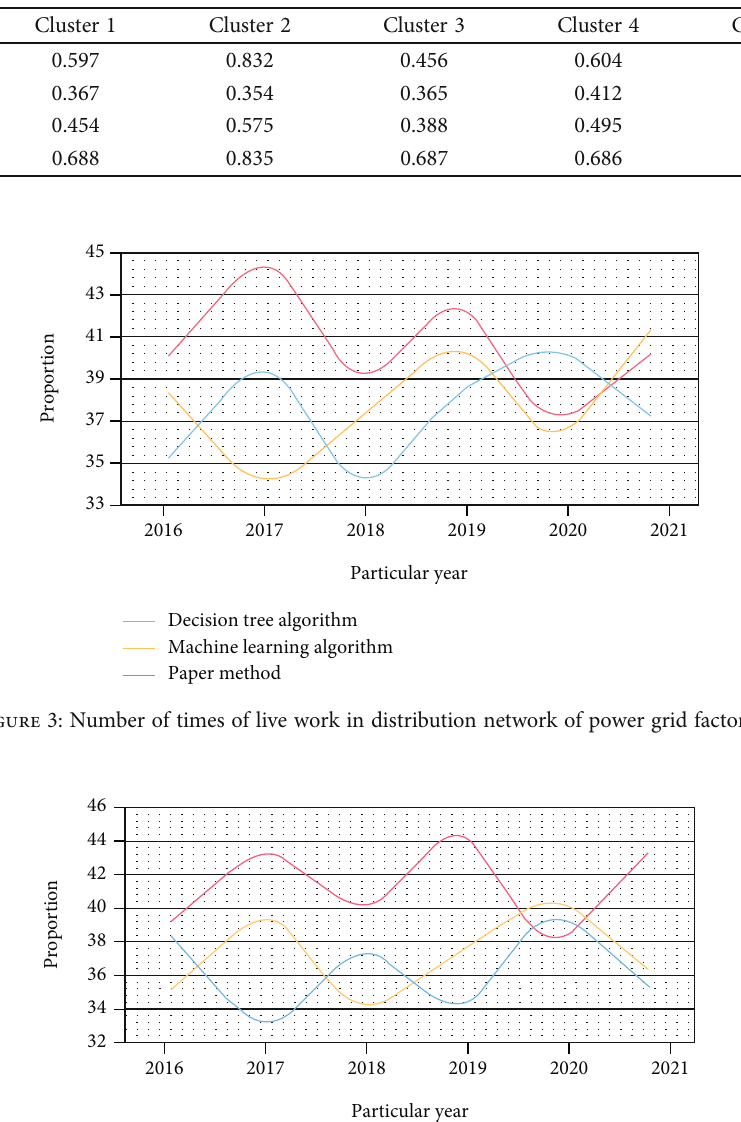
Table 6: KL divergence value when k is 6.